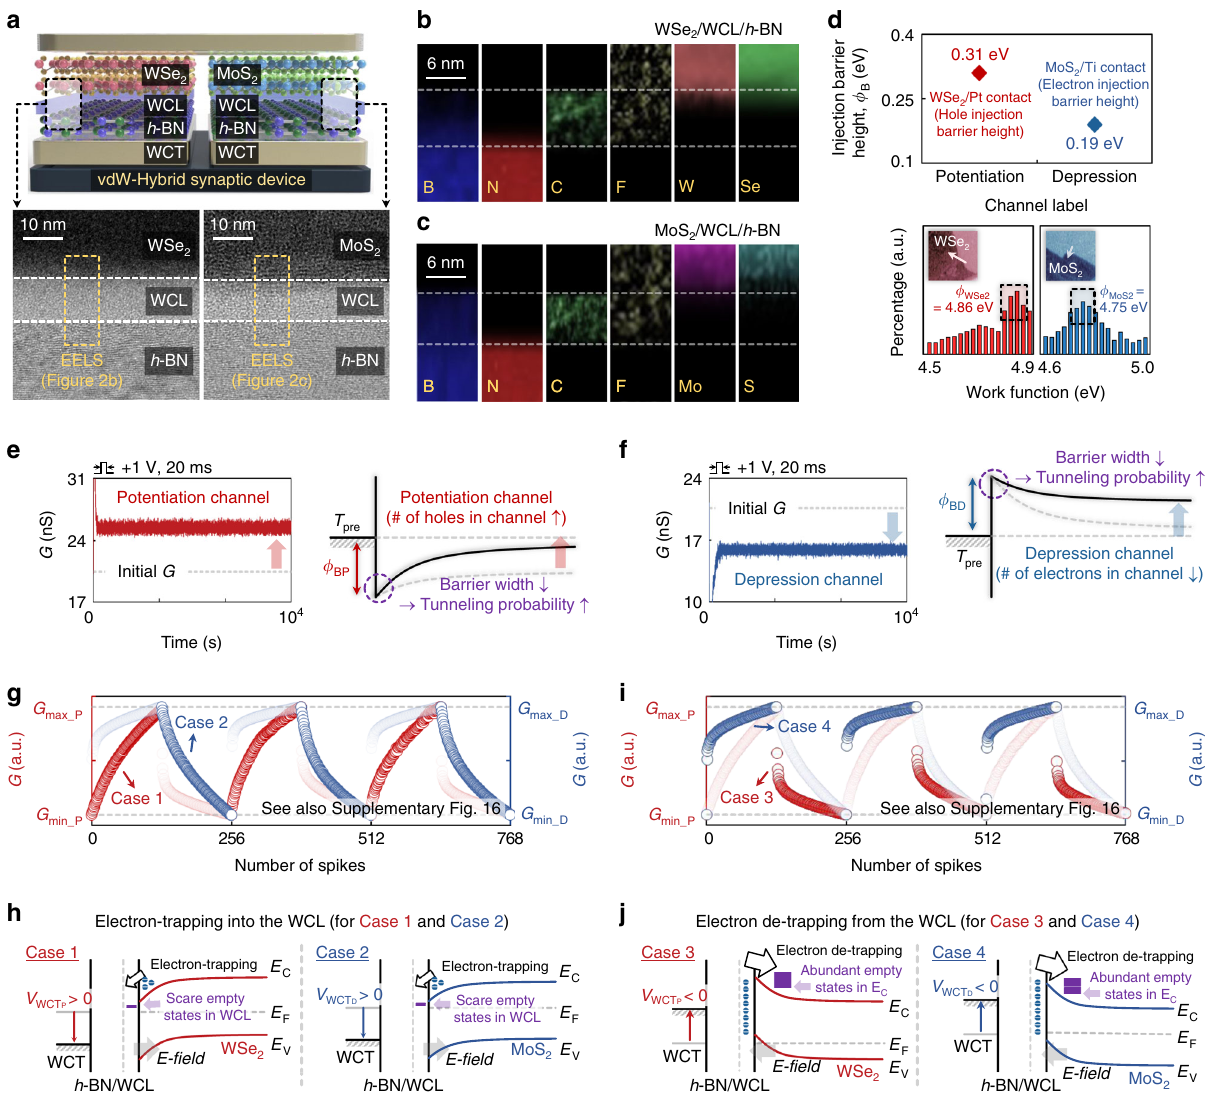
Fig. 2 Study on the weight control mechanism of the vdW-hybrid synaptic device. a X-TEM images of the WSe 2 /WCL/ h -BN (potentiation channel) and MoS 2 /WCL/ h -BN (depression channel) structures. b , c EELS mapping images obtained on the cross-sectional regions. d Extracted injection barrier height and work function for the potentiation and depression channels. e , f Excitatory ( e ) and inhibitory ( f ) PSC in the potentiation and depression channels. Illustration of energy band diagrams when an excitatory spike was applied to the WCTs for the potentiation and depression channels. g LTP curves through the WSe 2 channel (Case 1) and LTD curves through the MoS 2 channel (Case 2), where 128 excitatory spikes were applied in a row to the WCTs. h Illustration of energy band diagrams describing phenomena of electron trapping into the WCL. i LTP curves through MoS 2 channel (Case 3) and LTD curves through WSe 2 channel (Case 4), where 128 inhibitory spikes were applied in a row to the WCTs. j Illustration of energy band diagrams describing phenomena of electron detrapping from the